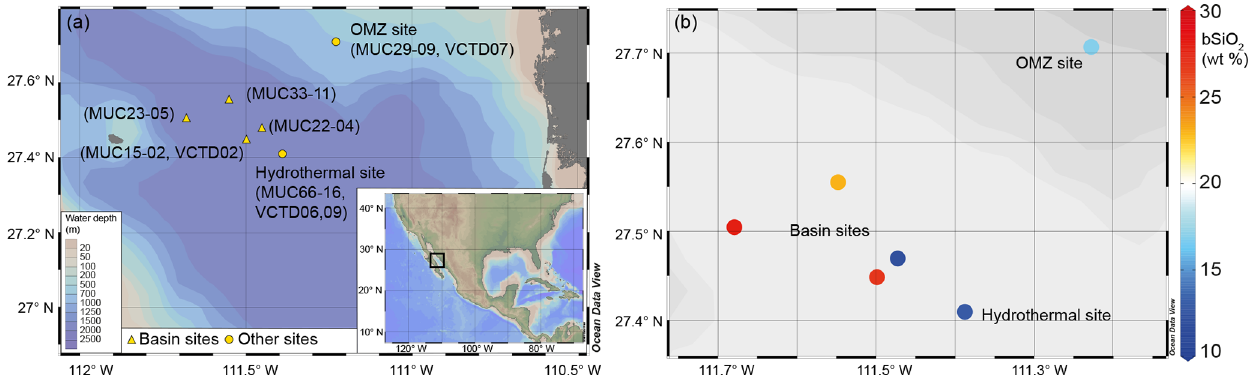
Figure 1. (a) Location map of the sampling stations in the Guaymas Basin, Gulf of California. The black square in the overview map indicates the sampling area. (b) Sedimentary bSiO 2 content at each sampling station. Water column stations were above MUC15-02 (VCTD02) in the basin, at the hydrothermal site (VCTD06, 09), and at the OMZ site (VCTD07).